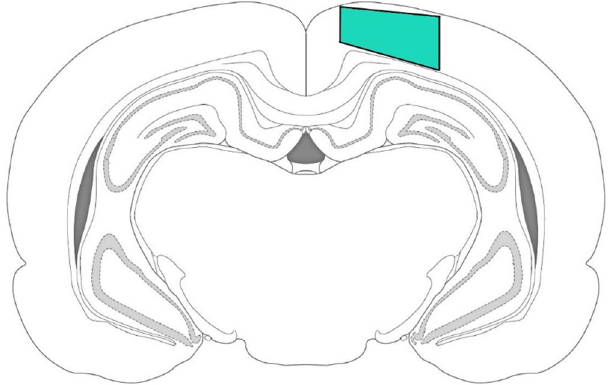
Figure 8. The approximate location of the ipsilateral cerebral cortex region where images for microglia quantification were taken (marked in green). Images were prepared with using GIMP 2.10.22 software (http://